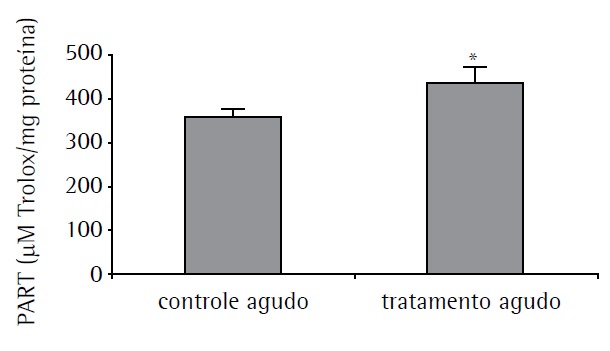
 Média dos níveis de potencial antioxidante reativo total (PART) nos
pulmões de ratos submetidos a administração aguda de metilprednisolona
(grupo de tratamento agudo) ou injeção de um volume igual de solução salina
(grupo de controle agudo). Trolox: ácido
2-carboxílico-6-hidroxi-2,5,7,8-tetrametilcromano. *p < 0,05, teste t de
Student.